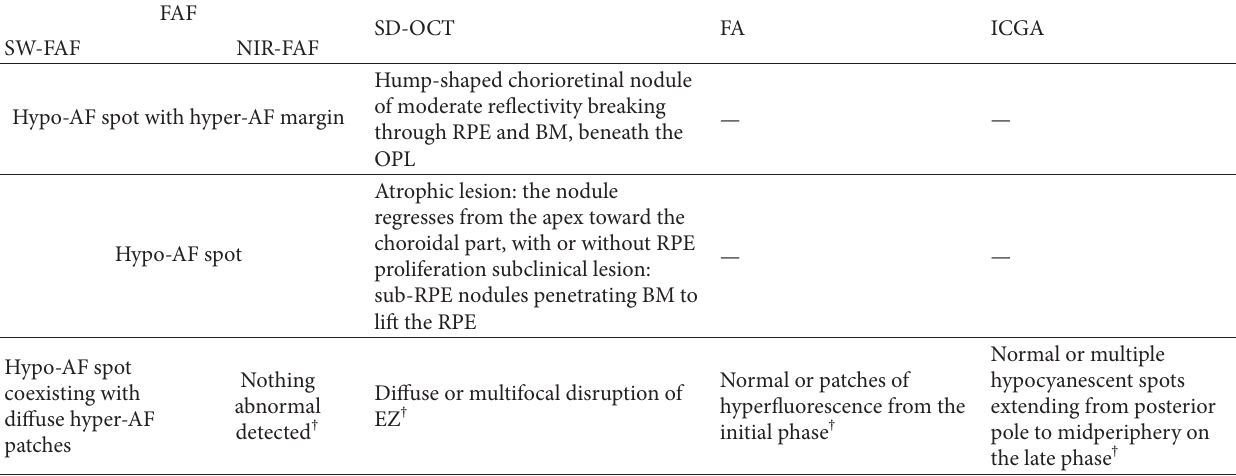
Table 1: FAF and corresponding SD-OCT, FA, and ICGA findings of punctate inner